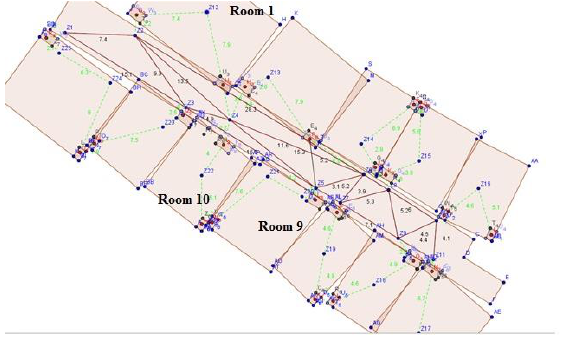
Figure 1: Floor plan by Trimble LaserAce 1000. Table 2: Measured slope distance (in meters), horizontal angles and vertical angles (in decimal degree) of top